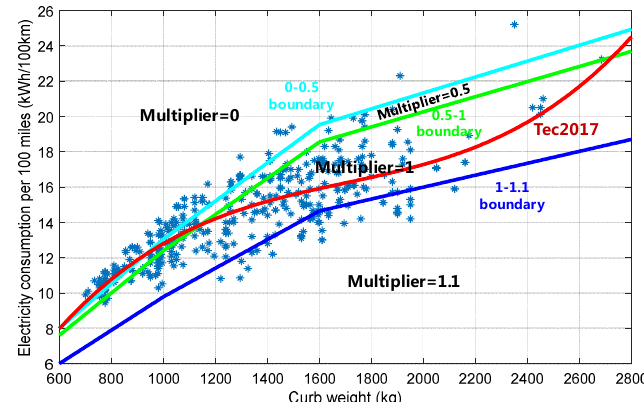
Figure 3. The electricity consumption rate and the multiplier β in China’s subsidy scheme. Notes. (1) The blue points are BEVs in the Chinese market. The red line represents the average electricity consumption rate in 2017. (2) The market is divided into four regions by three boundaries and the vehicles in each region receive a certain subsidy multiplier, i.e., 0, 0.5, 1, or 1.1, as indicated in Equation (1).